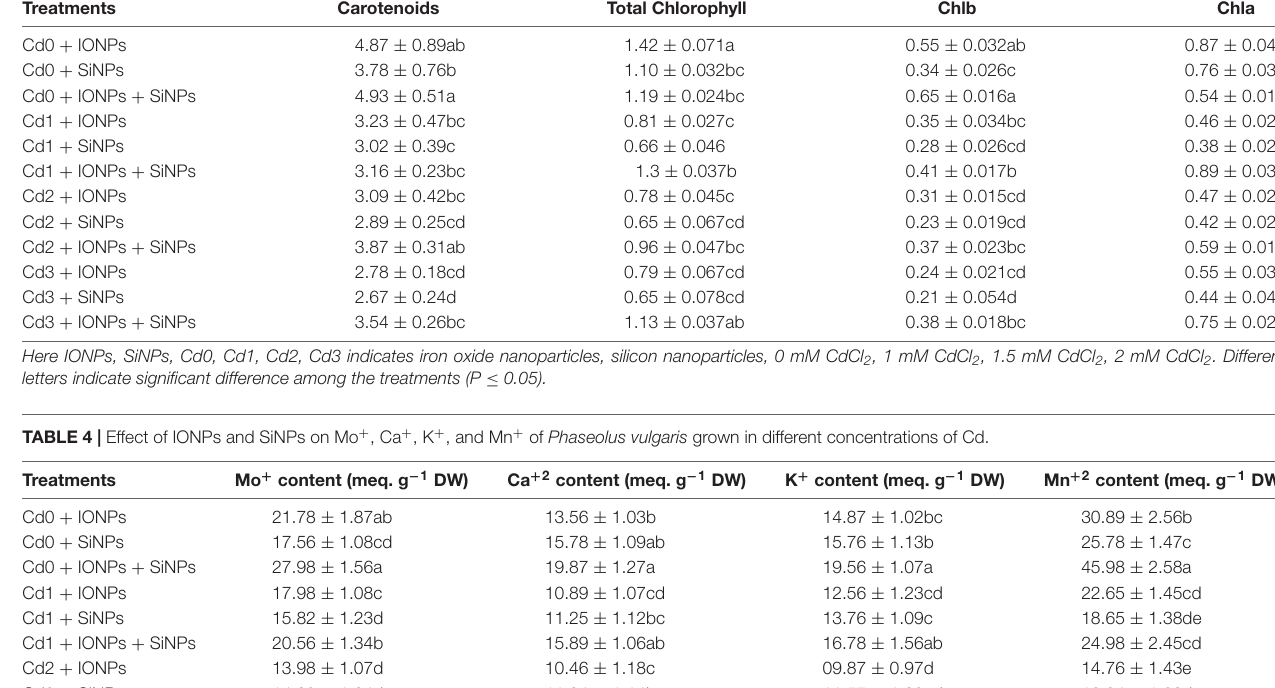
TABLE 3 | Effect of IONPs and SiNPs on carotenoids, total chlorophyll content, Chlb, and Chla of Phaseolus vulgaris grown in different concentrations of Cd. Treatments